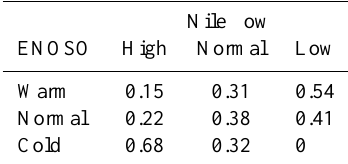
Table 4. Conditional probability of the Nile flow given ENSO con- ditions.